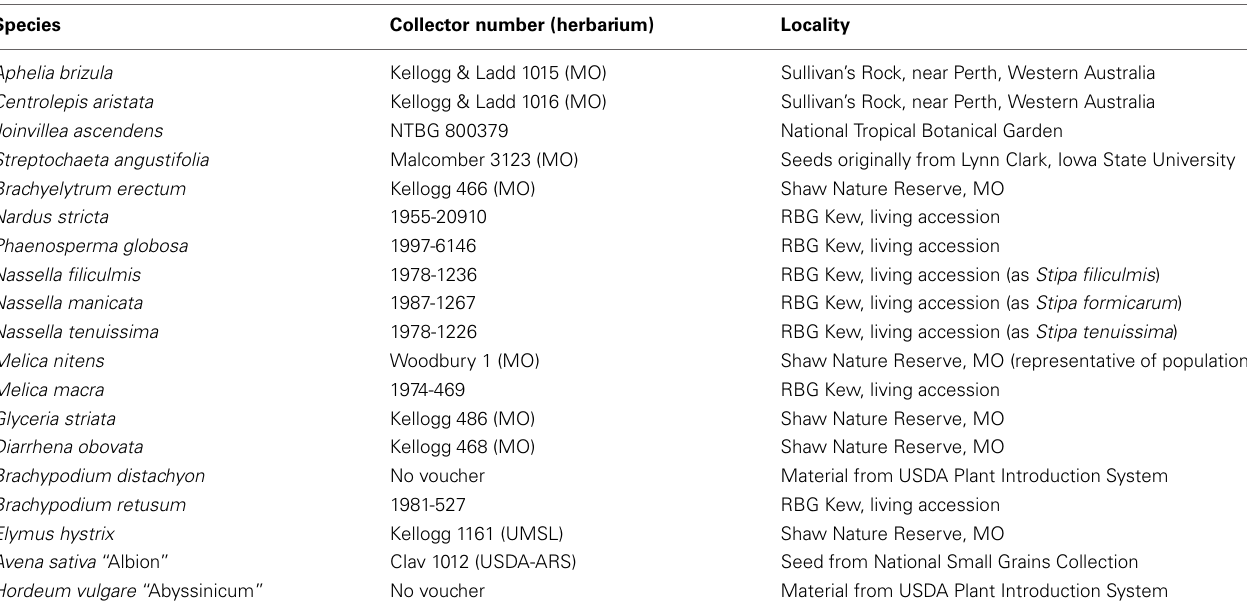
Table 2 | Voucher